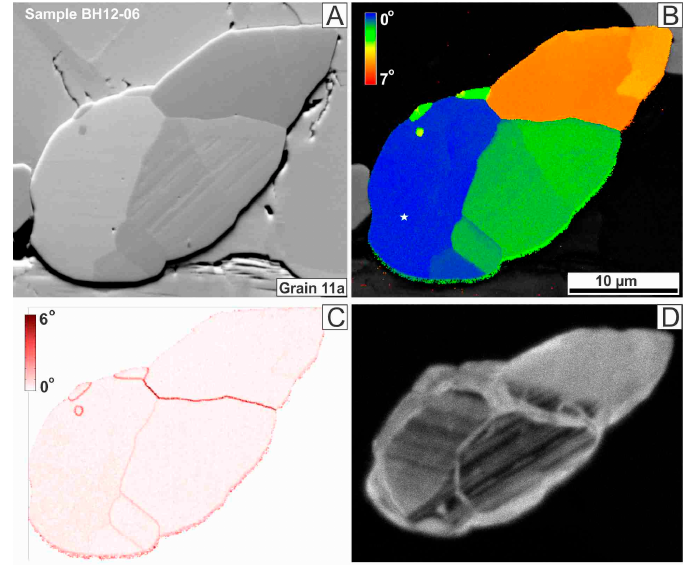
Figure 11. Data on the grain 11a, sample BH12-06. ( A ) Orientation contrast image. ( B ) Cumulative misorientation EBSD map, showing the orientation of every data point with respect to a user-selected reference point (white star). Misorientation within the grain varies from 0 (blue) to ca. 5° (orange). ( C ) Local misorientation EBSD map, showing misorientation of every pixel with respect to its neighbors. ( D ) Panchromatic CL image.